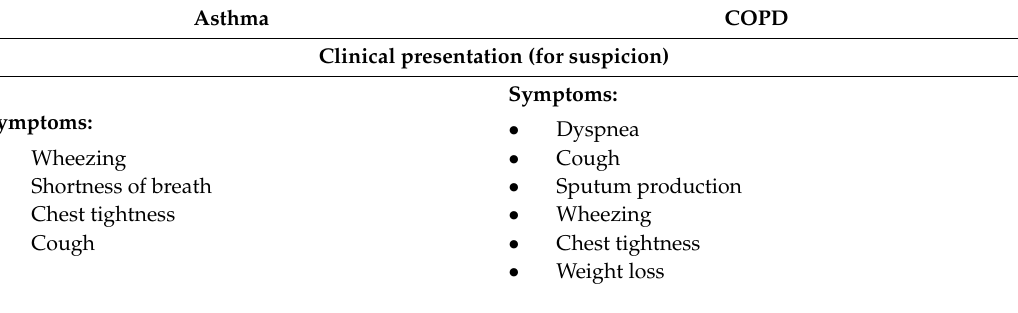
Table 1. Markers of asthma and chronic obstructive pulmonary disease (COPD) according to GINA (Global Initiative for Asthma) [11] and GOLD (Global Initiative for Obstructive Lung Disease) documents